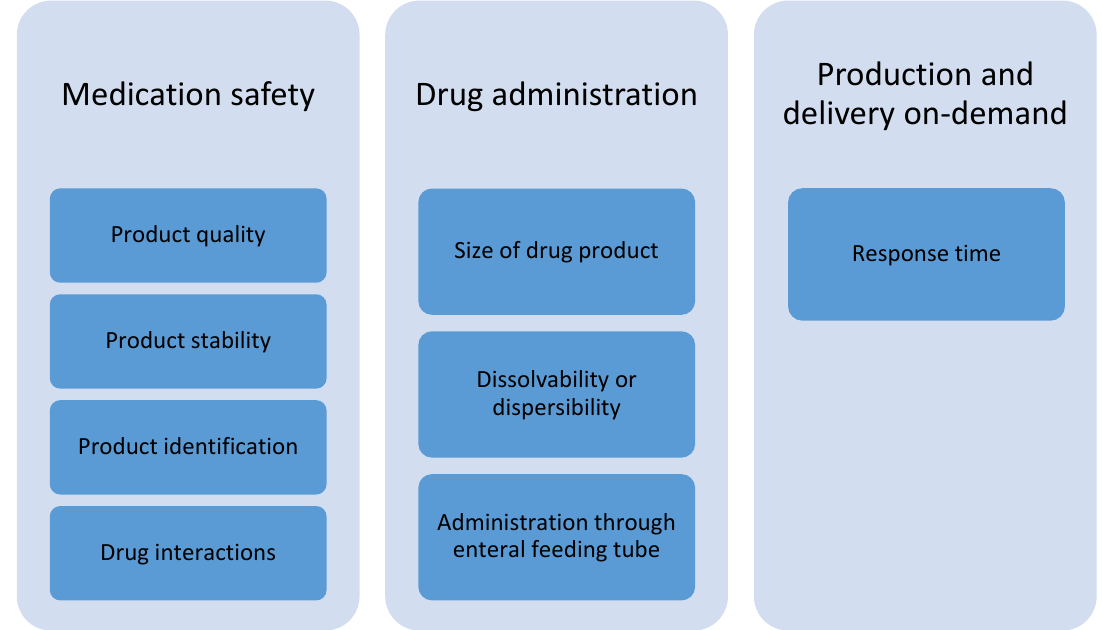
Figure 2. Identified subcategories of prerequisites for the adoption of 3D-printed drug products for pediatric patients at hospital wards.